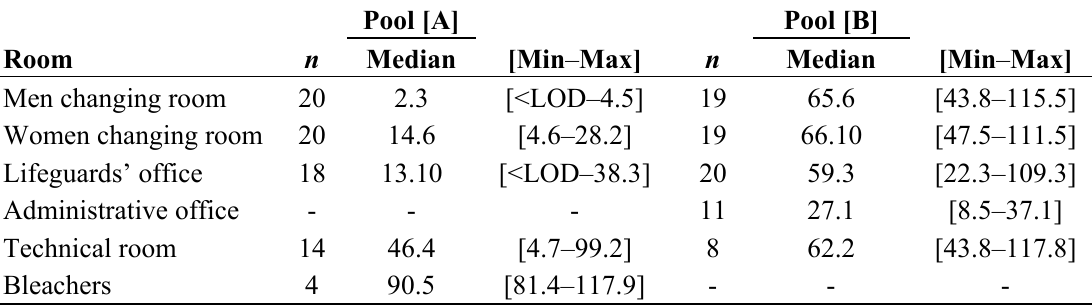
Table 5. TCM concentrations (µg/m 3 ) in the ambient air of various rooms of [A] and [B] (all